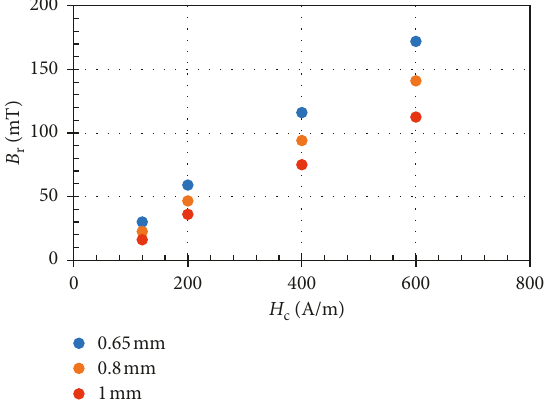
Figure 24: Maximum-to-remanent flux density ratio vs material